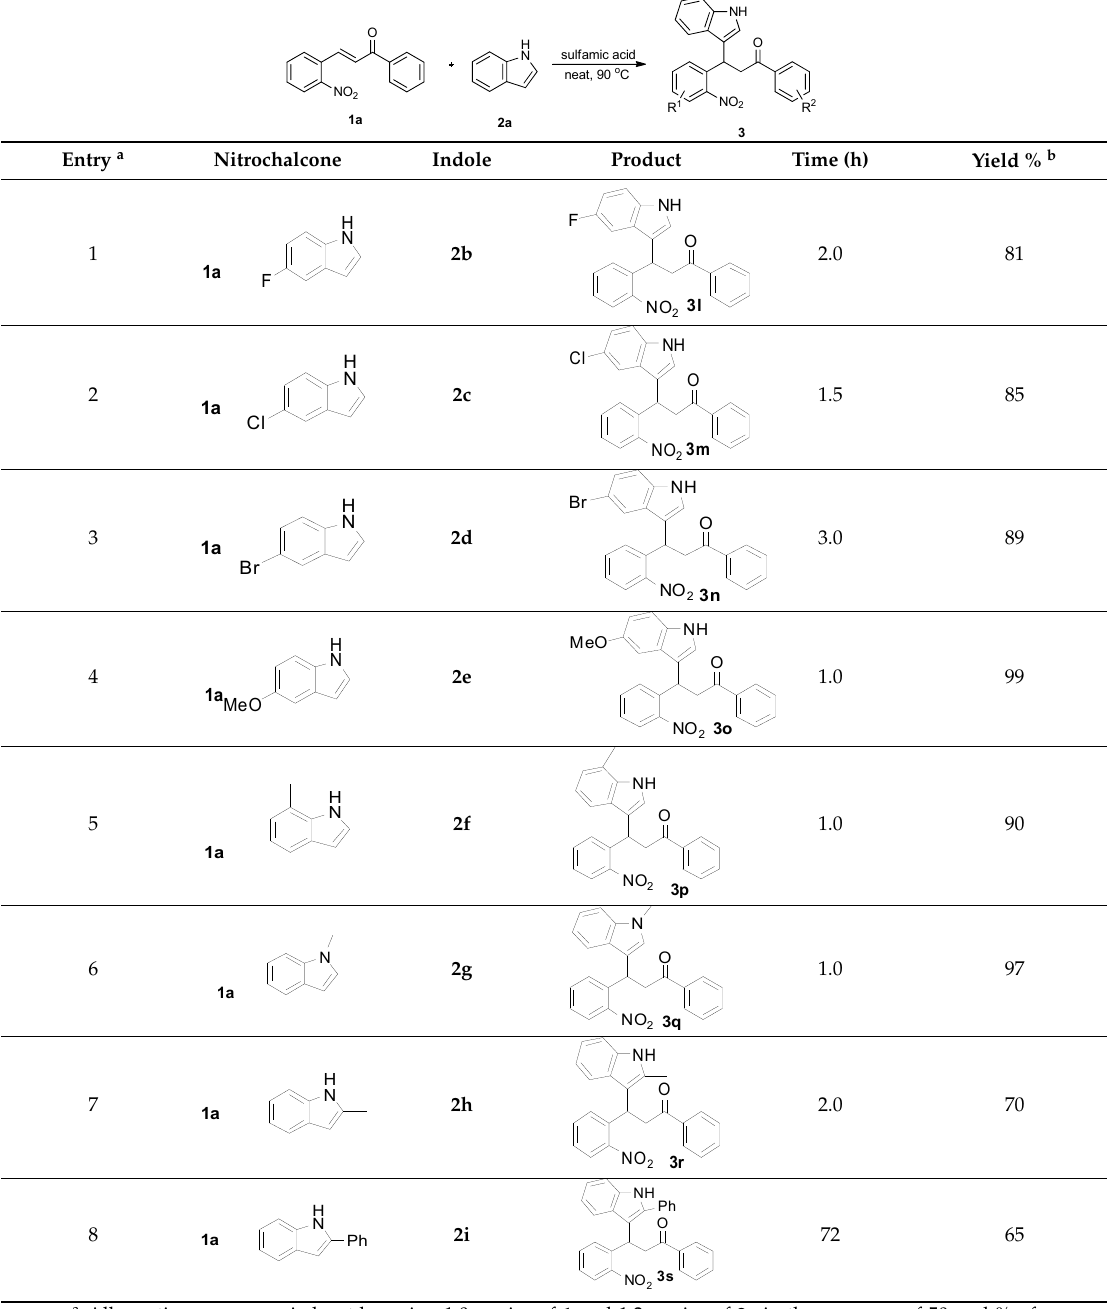
Table 2. Michael addition of 2-nitrochalcone ( 1a ) and various indoles.